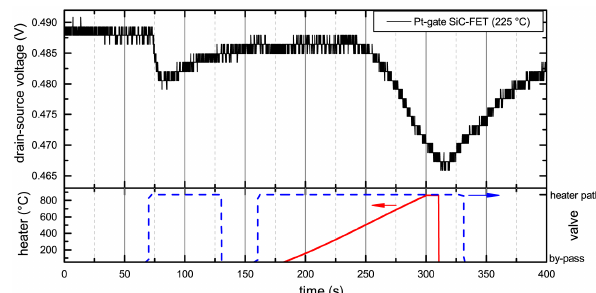
Figure 13. Sensor response of a Pt-gate SiC-FET at 225 ◦ C. Bot- tom: heating ramp and valve